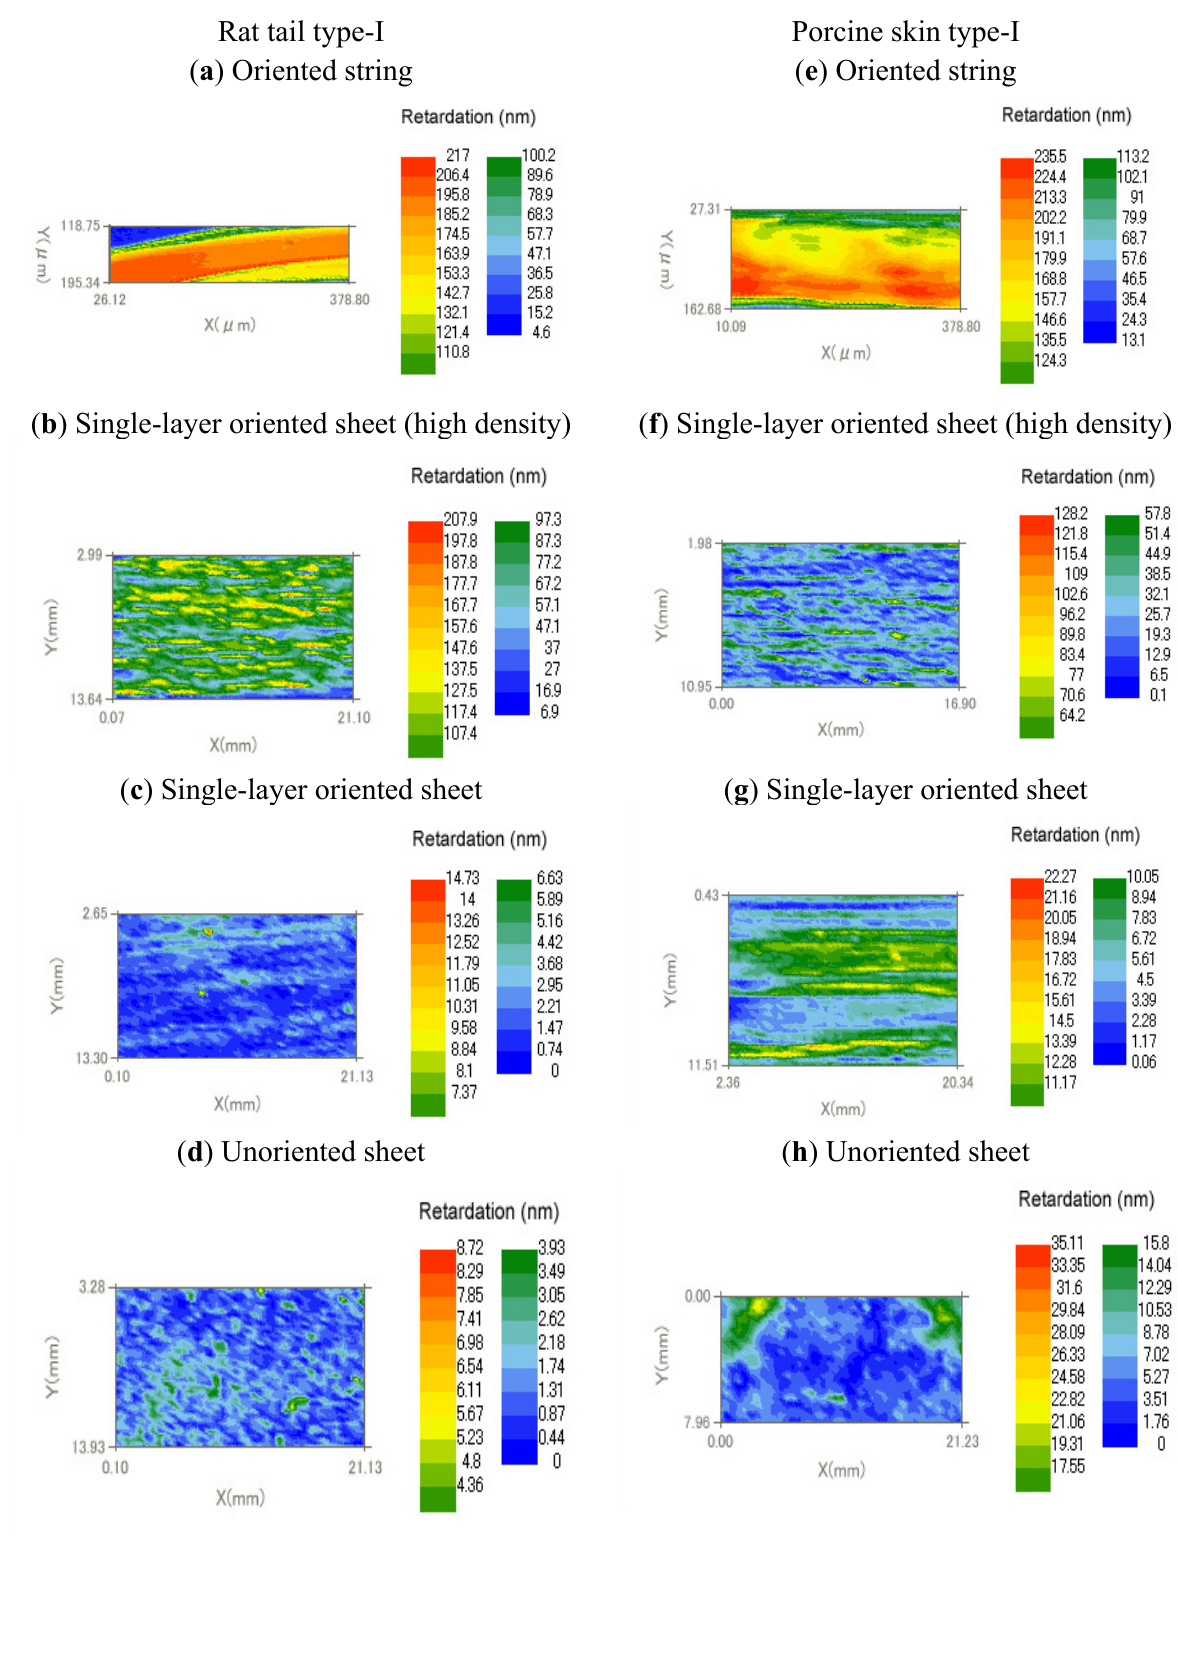
Figure 6. Retardation map of dehydrated oriented collagen